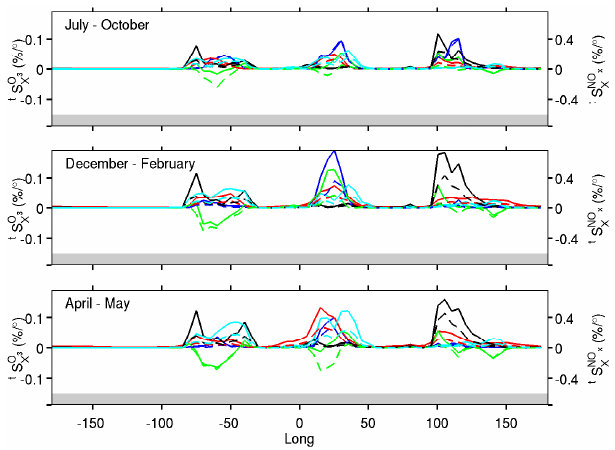
Fig. 7. Adjoint sensitivity of tropospheric ozone (solid lines) and NO x (dashed lines) over South America (shaded region) to changes in the emissions of isoprene (green), lightning NO x (red), biomass burning NO x (blue) and anthropogenic NO x